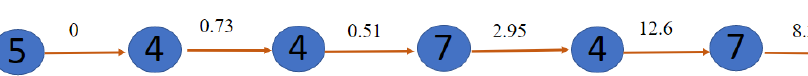
Figure 5. Directed weighted network.